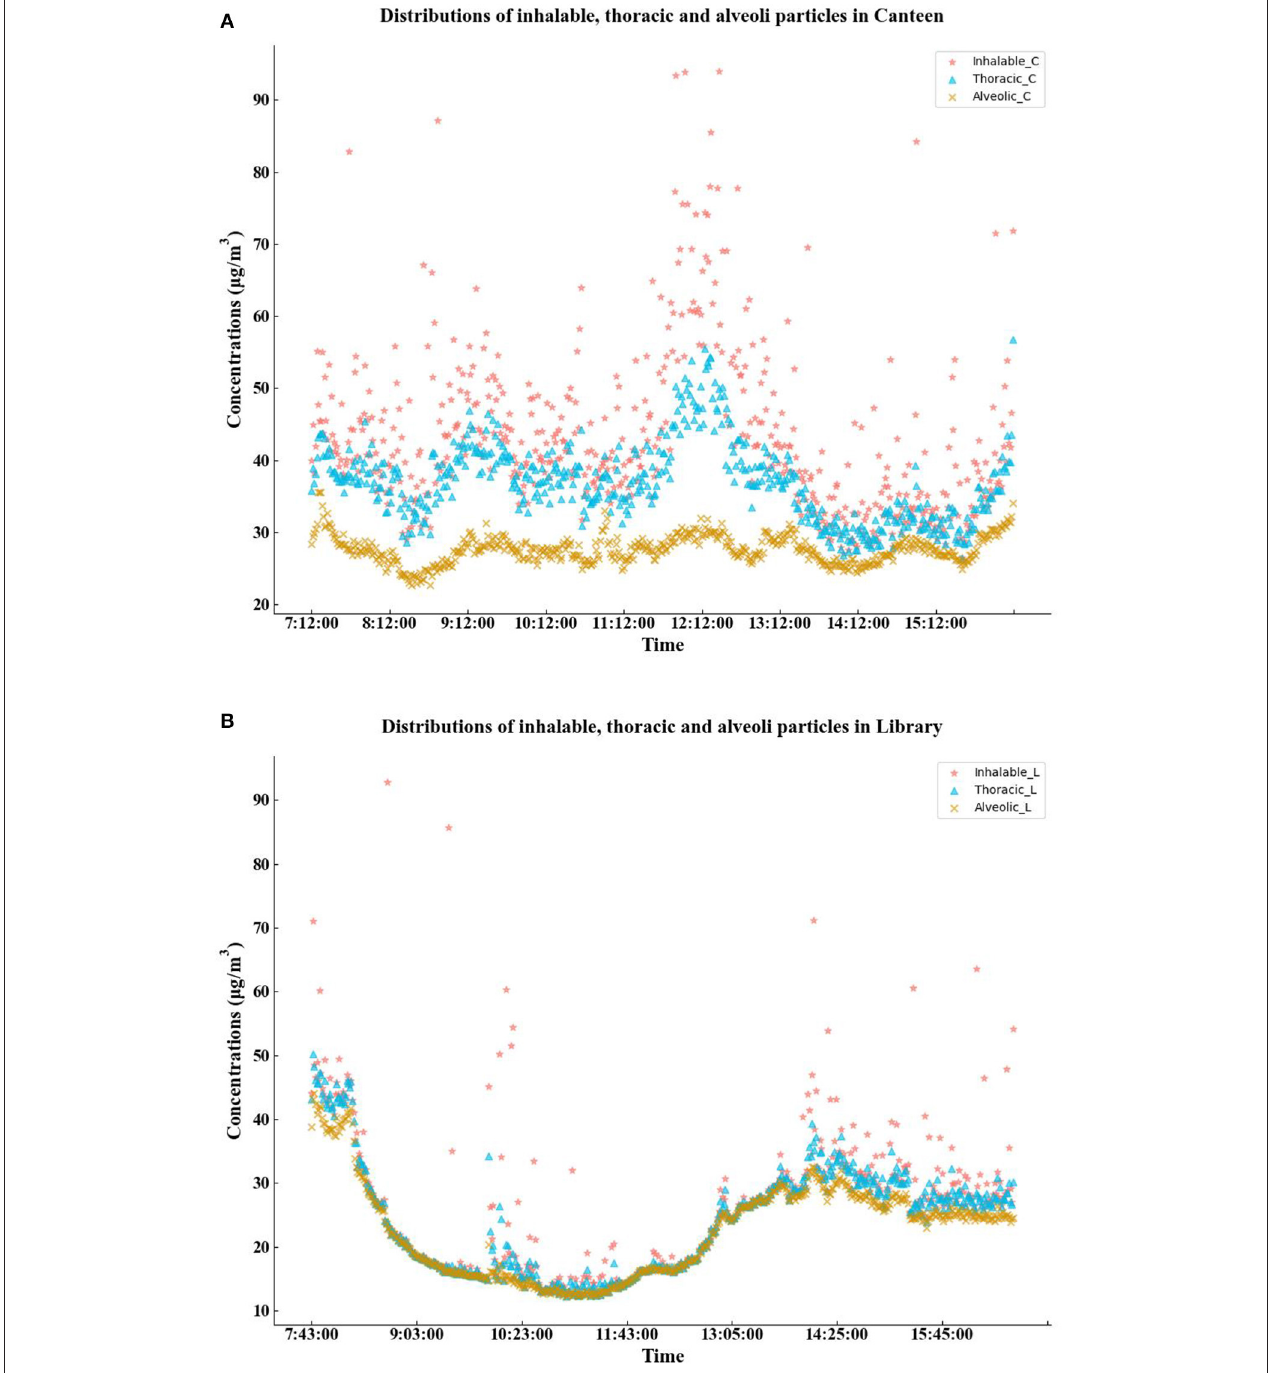
FIGURE 10 | Distributions of inhalable, thoracic, and alveoli particles in the canteen and